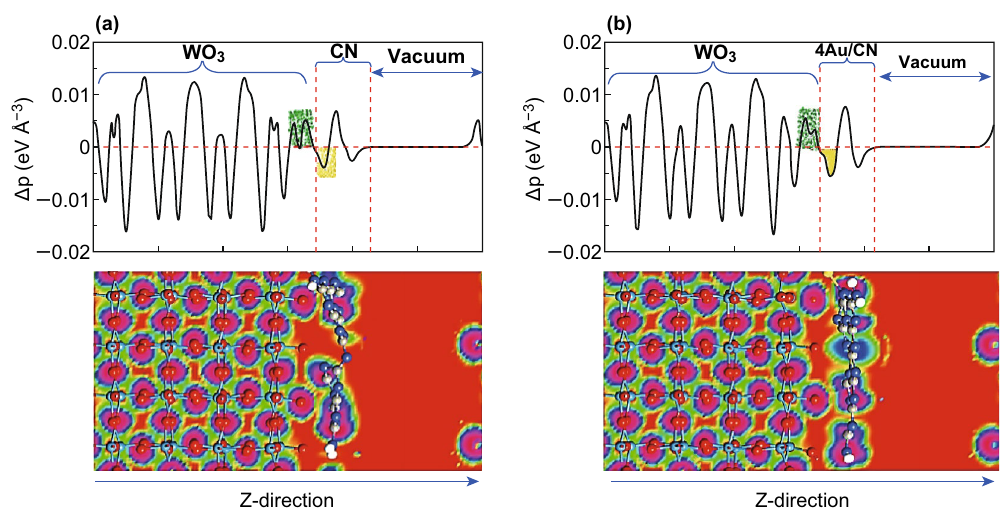
Fig. 4 Average electron difference density along with electrostatic potential maps of a 6WO 3 /CN and b 4Au/6WO 3 /CN composites. The green and yellow shaded areas denote electron accumulation and donation, respectively. (Color figure